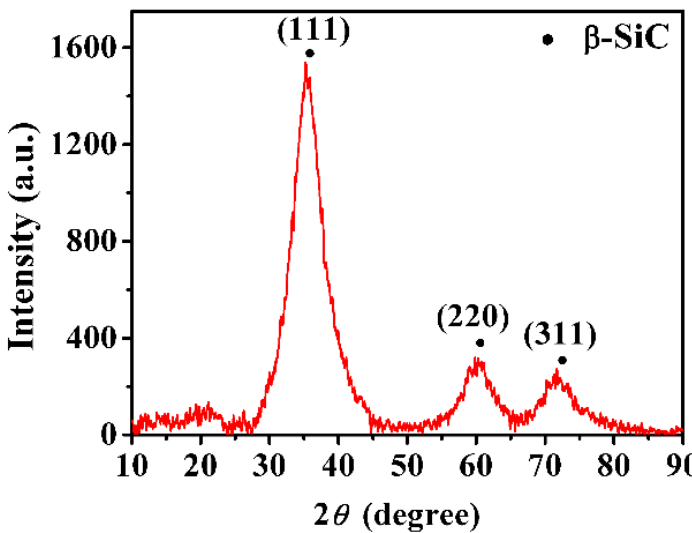
Figure 3. XRD pattern of the as-prepared SiC f /SiC m composites.